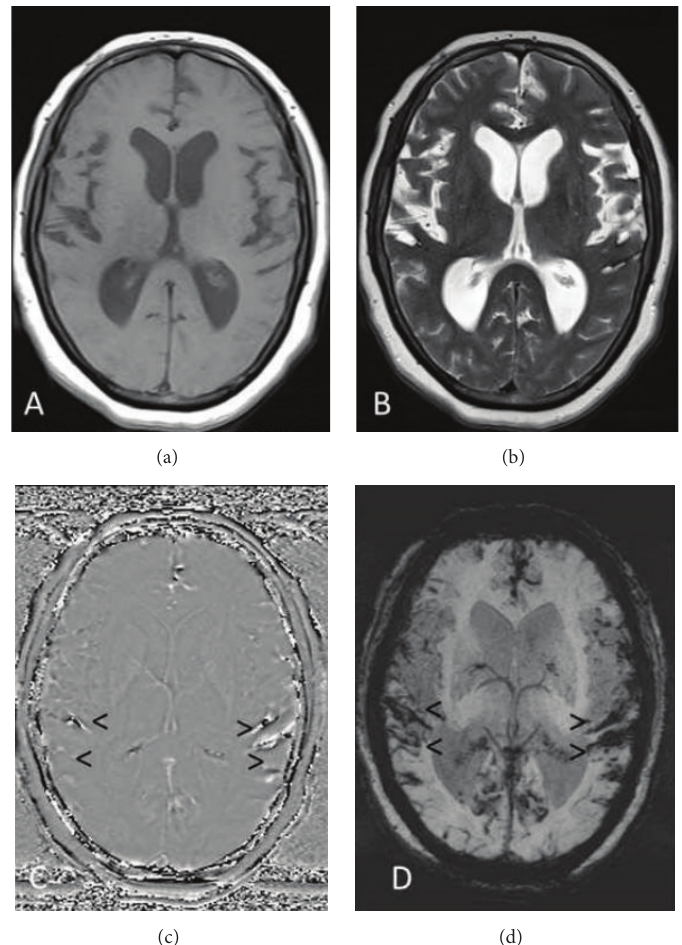
Figure 1: Axial sections of the brain: (a) T1 weighted and (b) T2 weighted images showing mild effacement of the sulci. Positive phase shift and blooming along the sulcal spaces (arrow heads) on (c) phase and (d) MIP (susceptibility weighted) images suggestive of superficial